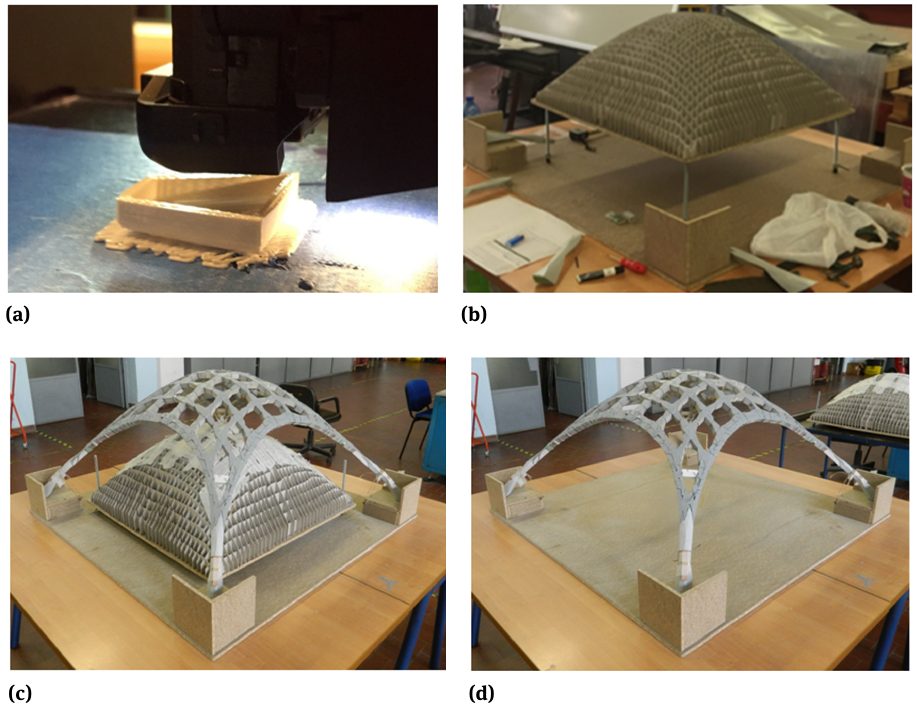
Figure 10: 3D printing with FDM of the formwork (a). To support the bricks during the prototype realization, a spar were realized with cardboard (b) Removing phase of the spar (c). The structure is realized